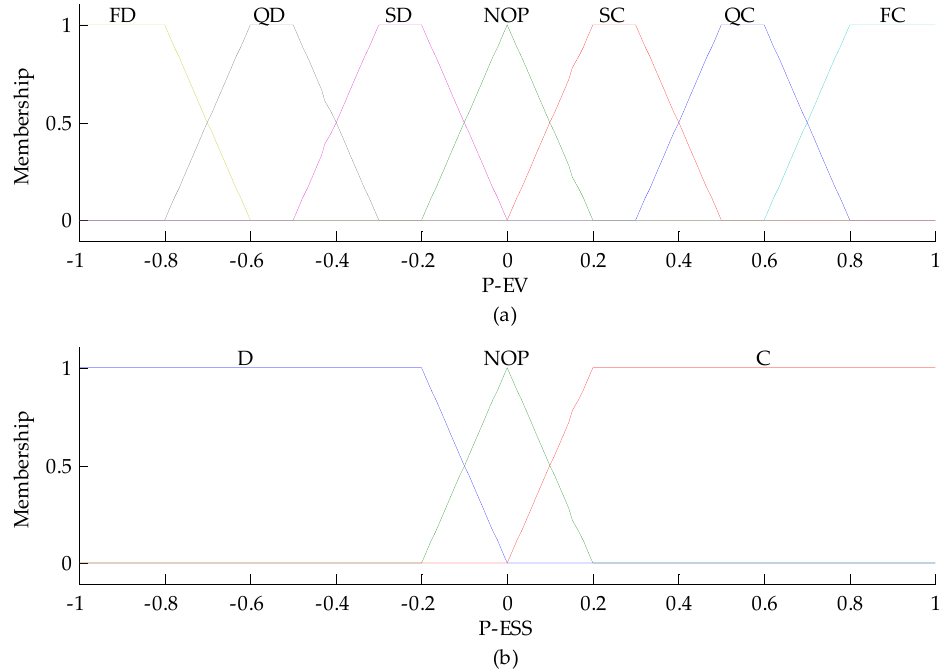
Figure 4. Membership function of output variables on weight of ( a ) EV charging / discharging power and ( b ) ESS charging / discharging power.